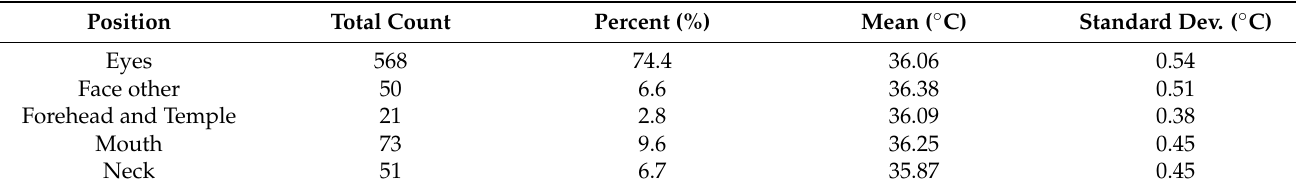
Table 1. Locations of the maximum face temperature.